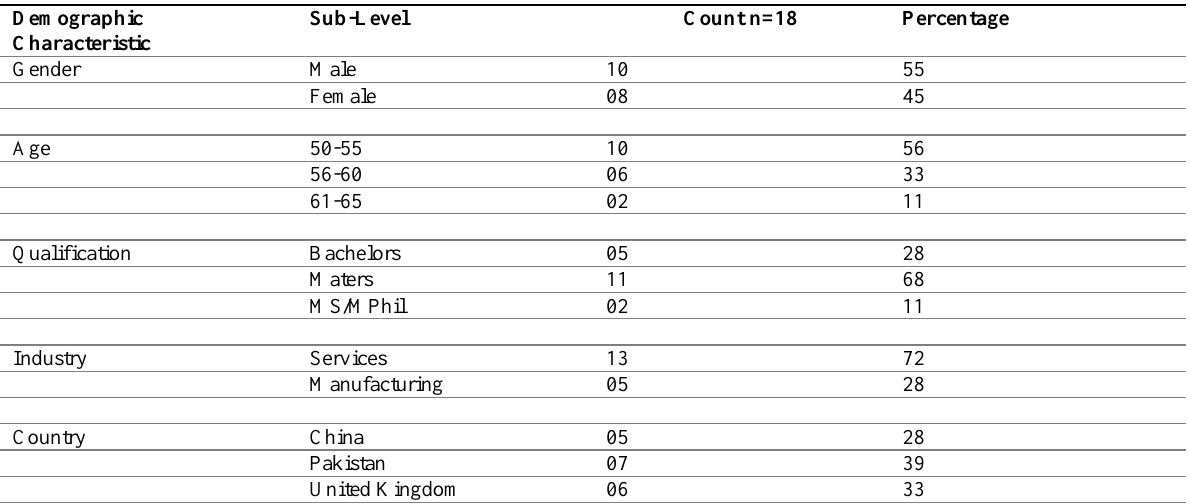
Table 1: Demographic Analysis of Research